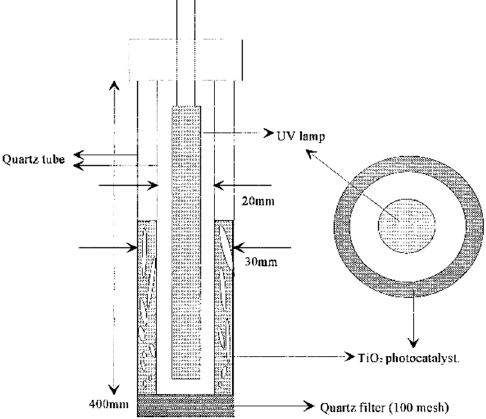
Figure 17. Modified two-dimensional fluidized-bed photoreactor. Reproduced with permission from